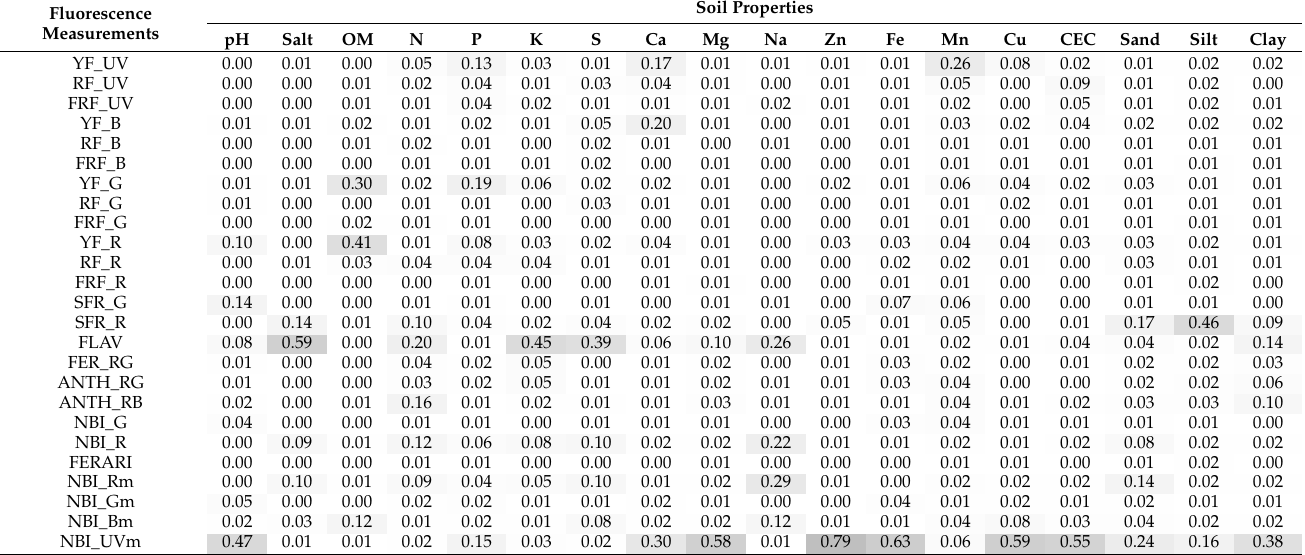
Table 7. Random Forest Regression feature or optical measurement importance for each soil param- eter. The Mean Decrease in Impurity (MDI) scores are indicated along with a grayscale gradient showing higher values in darker gray tones. The sum of each column is equal to